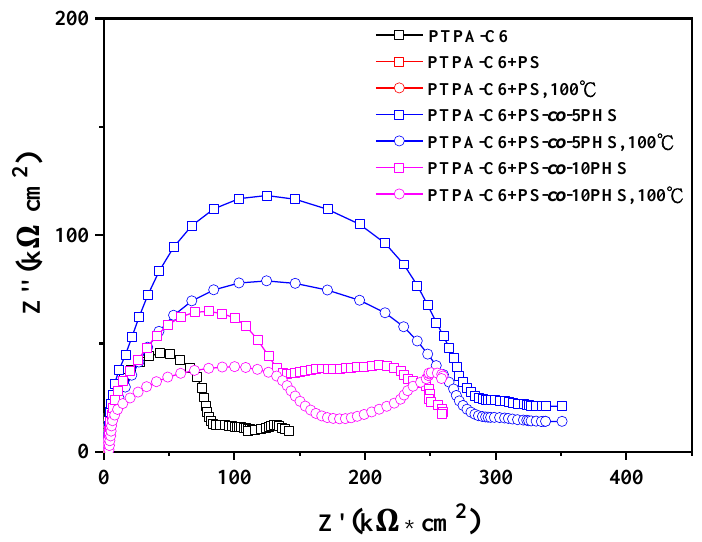
Figure 6. Nyquist plots of the PTPA-C6, PTPA-C6/PS, PTPA-C6 /PS- co -5PHS, and PTPA-C6/PS- co - 10PHS blends coated on iron substrate in 3.5% NaCl solution.